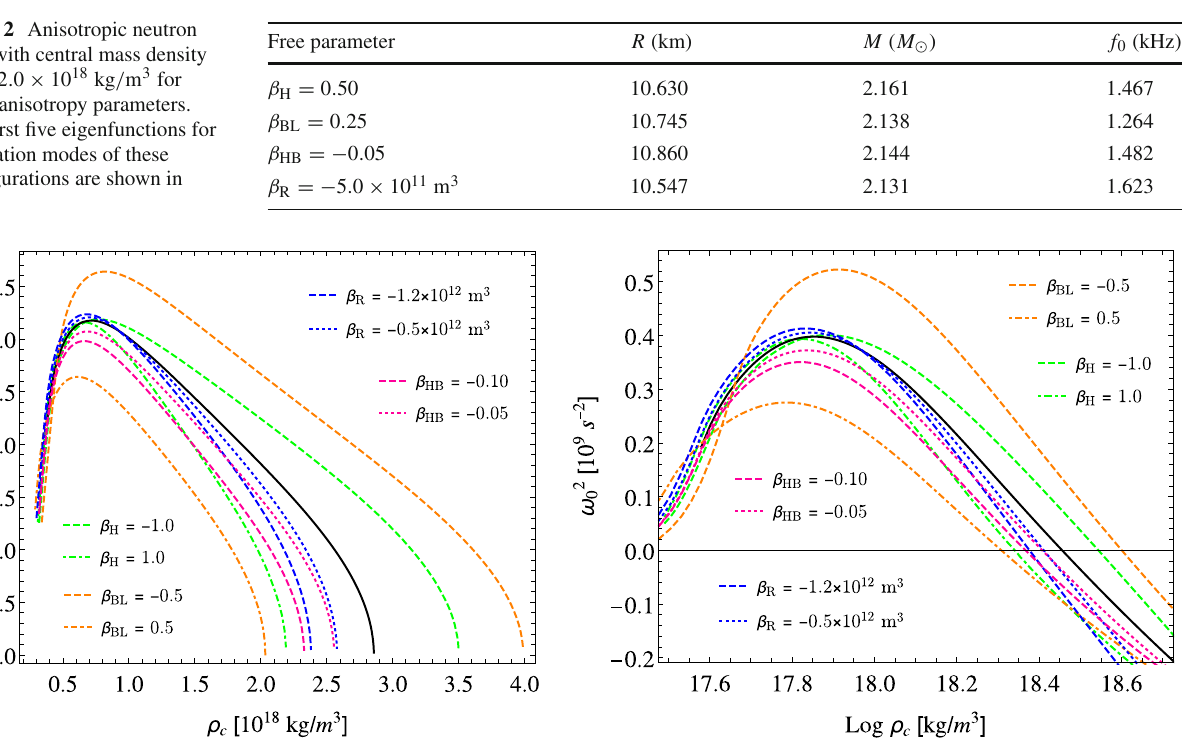
against the central density for different values of oscillation mode ω 2 0 β . The isotropic case is shown in both plots as a benchmark by a solid black